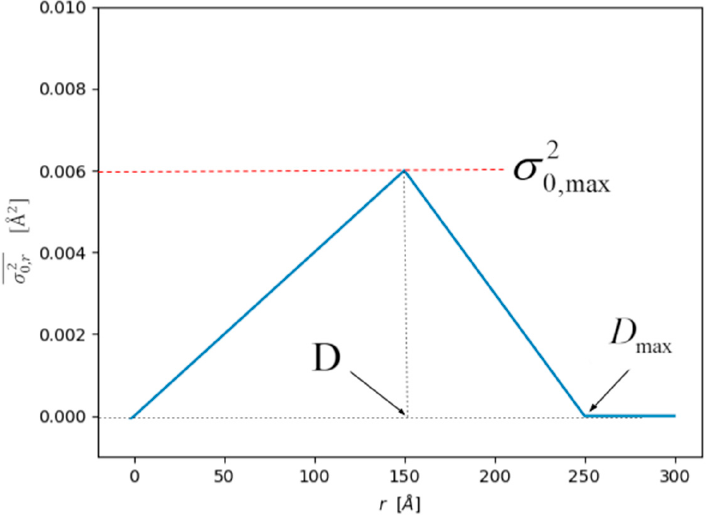
Figure A1. Graphical explanation of Equation (A9). The function is a simplification of the static component trend calculated from MD simulations.